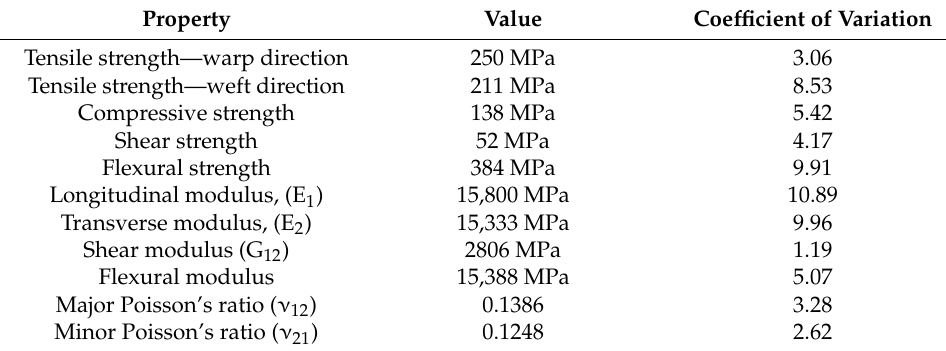
Table 2. Properties of glass-fiber-reinforced polymer